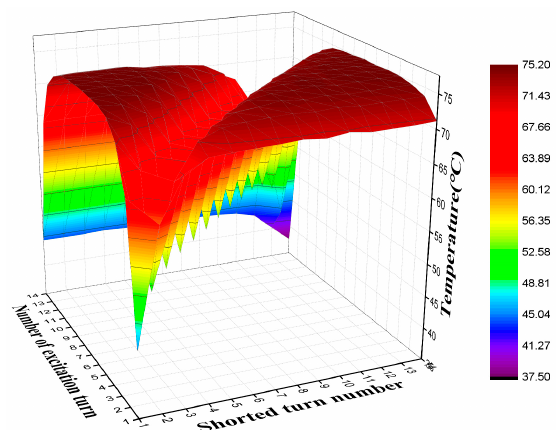
Figure 6. Rotor pole temperature field of one-turn short circuit of rotor winding: ( a ) inter-turn fault of No. 6; and ( b ) inter-turn fault of No. 12.